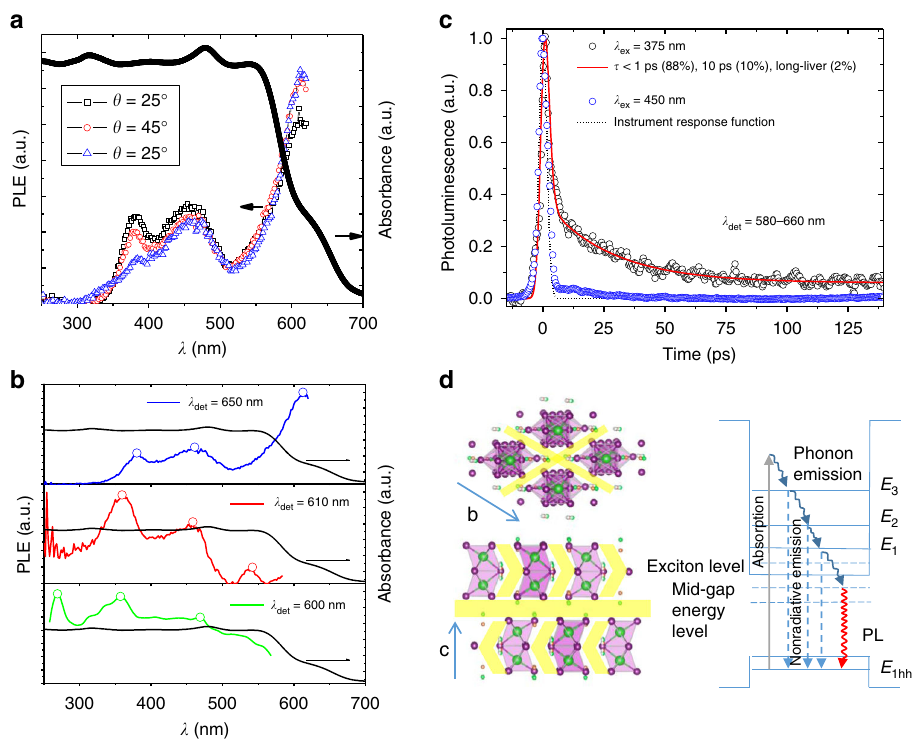
Fig. 4 Excitation property of the charge carriers. a Ultraviolet – visible absorption derived from diffuse re fl ectance spectra of (CH 3 NH 3 ) 3 Bi 2 I 9 and the angular dependence of photoluminescence excitation (PLE) of 650 nm emission ( λ det = 650 nm) at 25°, 45° and 65°. b PLE spectra for emission at λ det = 650, 610 and 600 nm while keeping incident angle, θ , at 45°. The open circles show the major PLE peaks. c Time-resolved photoluminescence of the coating placed at θ = 0° under a excitation beam of 375 nm ( λ = 375 nm) and 450 nm ( λ = 450 nm). d Schematics of quantum-well structure and multiphonon ex ex relaxation. The mid-gap energy level is from the organic termination. E hh represents the energy level of heavy hole state, while E 1 , E 2 and E 3 show the discrete energy levels in the conduction